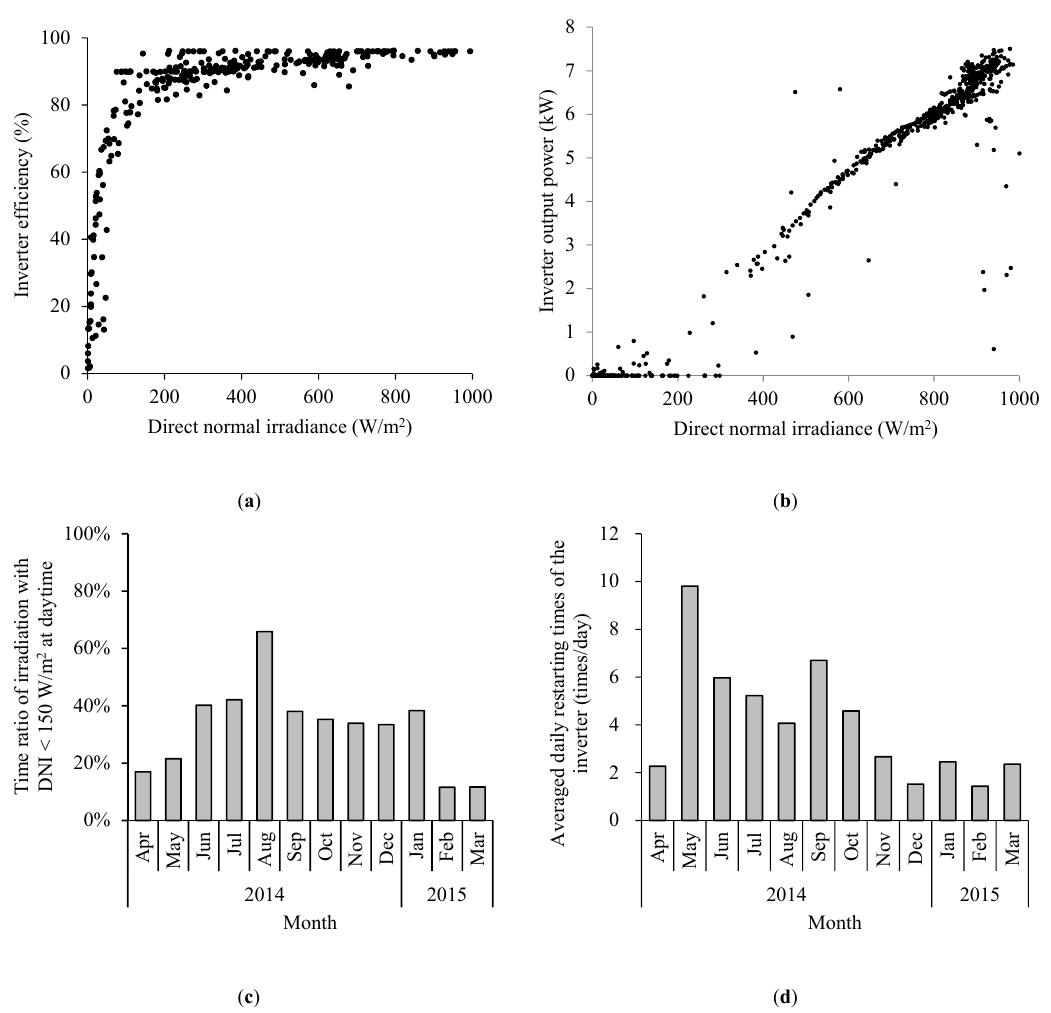
Figure 5. ( a ) Efficiency of the inverter plotted as a function of direct normal irradiance; ( b ) Output power of the inverter plotted as a function of the direct normal irradiance during a typical day; ( c ) Monthly proportion of time when DNI < 150 W/m 2 during the daytime period; ( d ) Monthly averaged daily restarting times of the inverter.